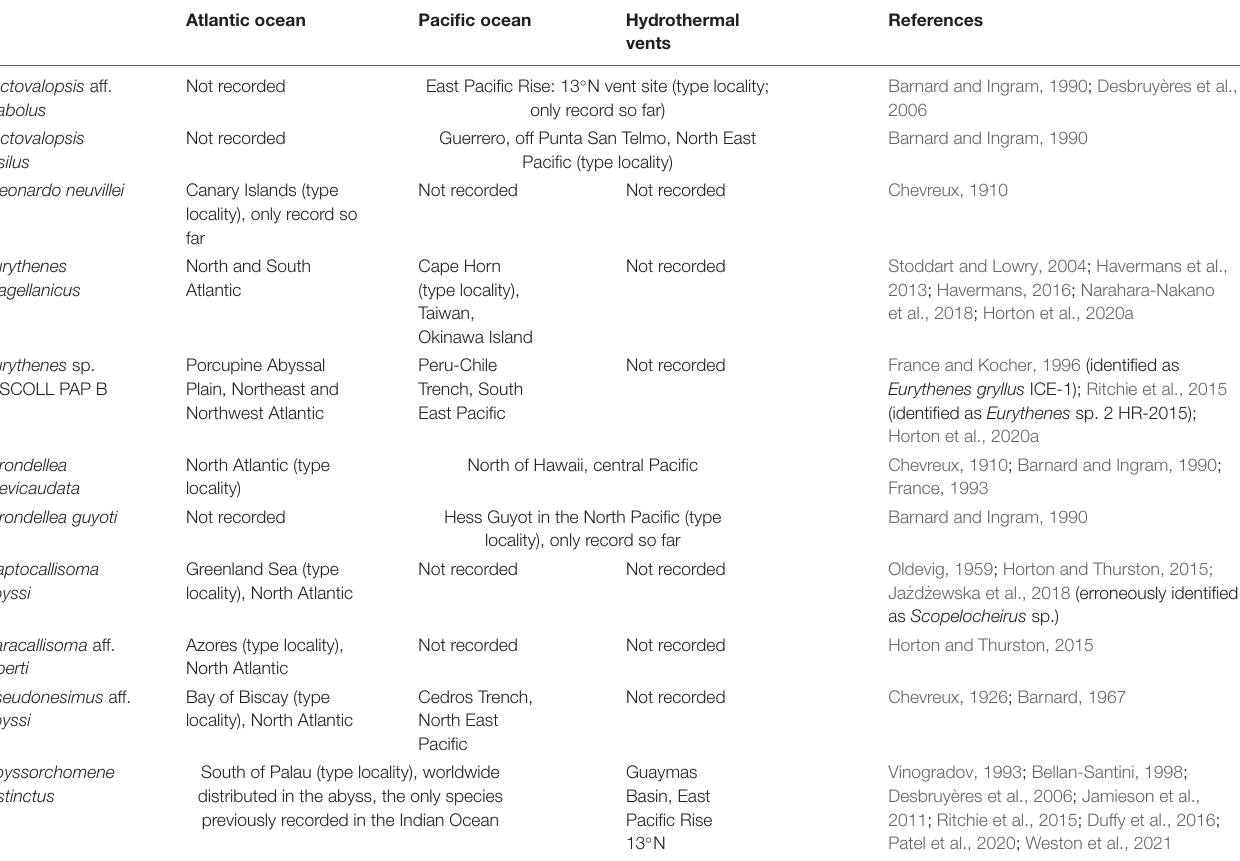
TABLE 6 | Summary of known distribution of presently sampled species indicating the presence at hydrothermal vent